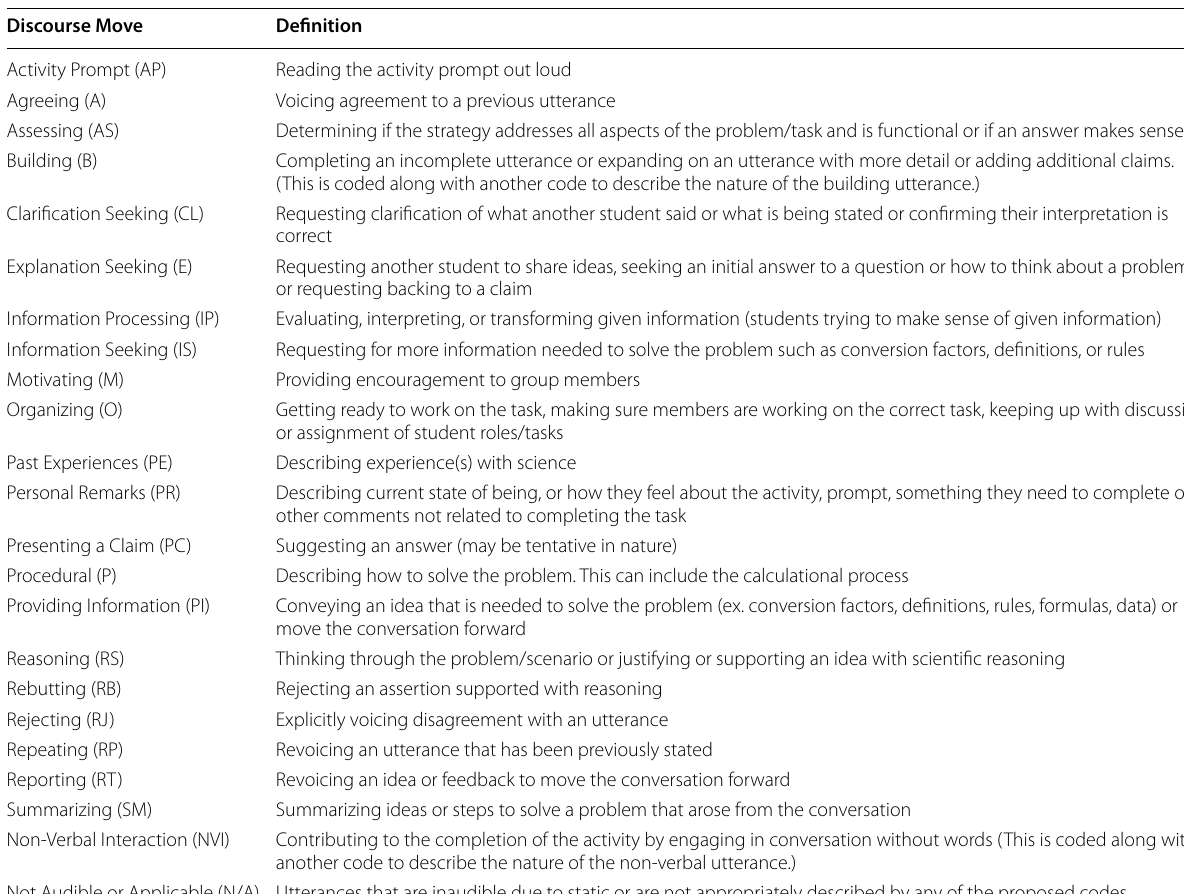
Table 3 Definitions of student interaction discourse moves nature of utterance codes. Abbreviations of each discourse move are in parenthesis next to the name of the